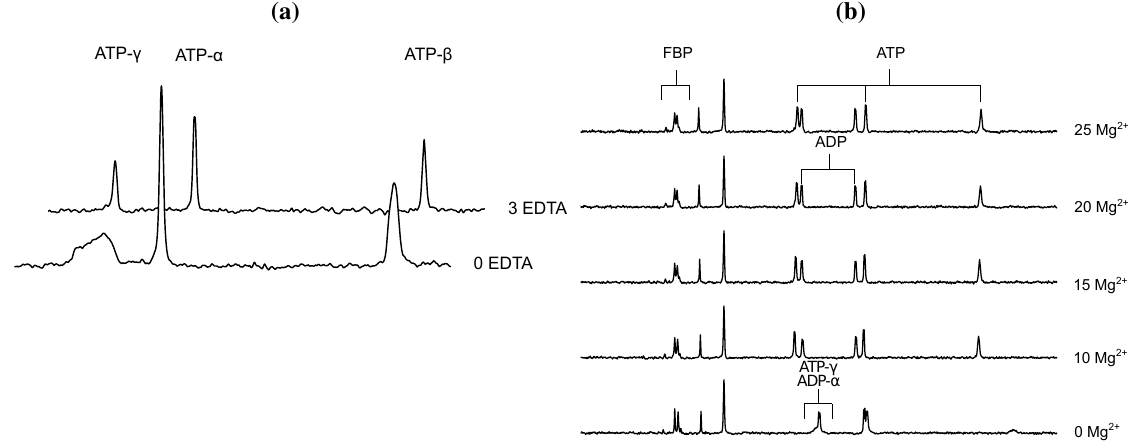
Figure 2. 31 P NMR (a) The e ff ect of EDTA on the line shapes of ATP using 31 P NMR. Spectra were collected with a 90 ◦ pulse angle and repetition time of 1 s (0.5 s acquisition time, 0.5 s relaxation delay). ATP concentration was 5 mM; (b) MgCl and ADP and the e ff ect on 31 P NMR spectral o ff set and line shape. Spectra were collected with a 60 ◦ pulse angle and repetition time of 1.3 s (0.8 s acquisition time, 0.5 s relaxation delay). FBP, ATP and ADP concentrations were 10 mM, and the indicated concentration of MgCl (in mM) was added. All other parameters are described in Section 3.3. Raw NMR 2 FID data are included as supplementary